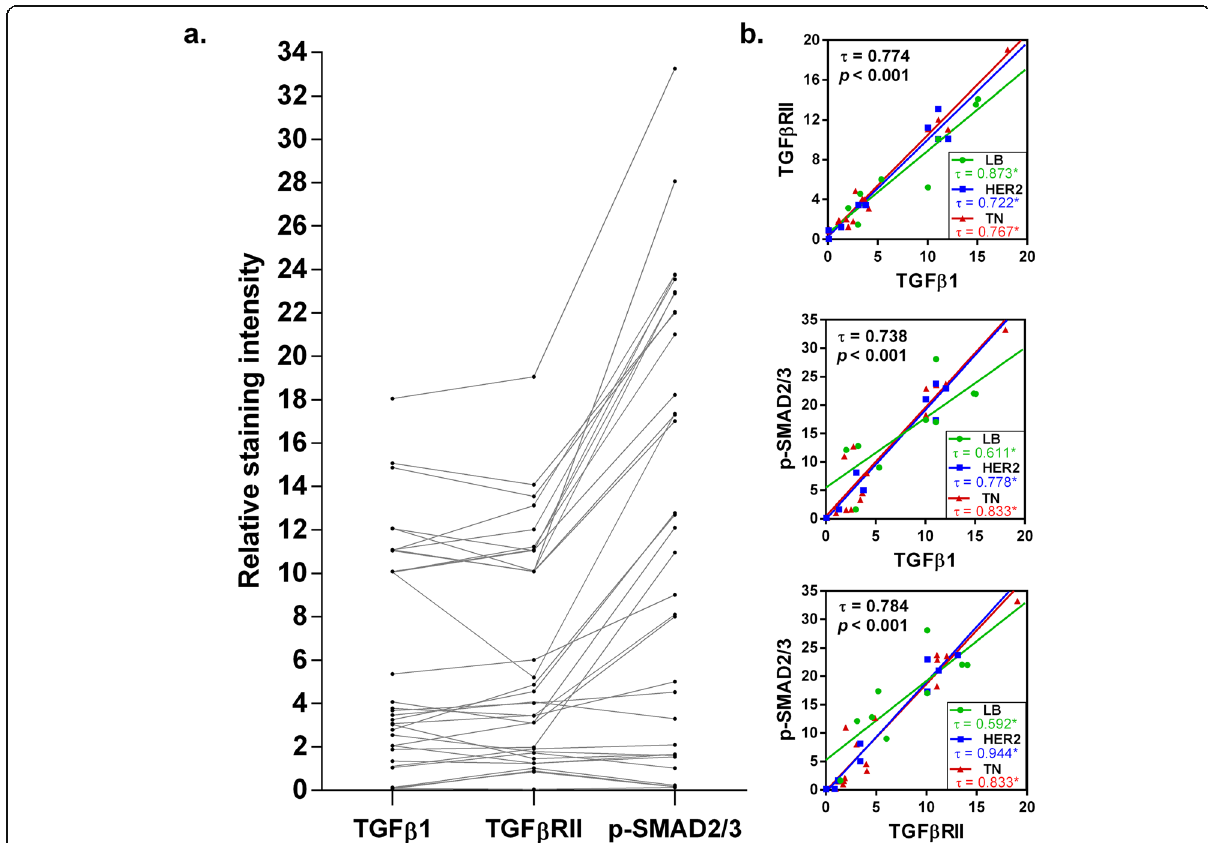
Fig. 3 Correlation between TGF β 1, TGF β RII and p-SMAD2/3 in breast cancer tissue. a Distribution of data regarding TGF β 1, TGF β RII and p- SMAD2/3 immunostaining in BC tissue. Lines connect data from the same patients. b Correlation between TGF β 1 and TGF β RII, TGF β 1 and p- SMAD2/3 and between TGF β RII and p-SMAD2/3. Tau-b correlation coefficient and p- values are shown within each graph. LB: Luminal-B-HER2 + subtype. HER2: HER2-enriched subtype. TN: triple-negative subtype